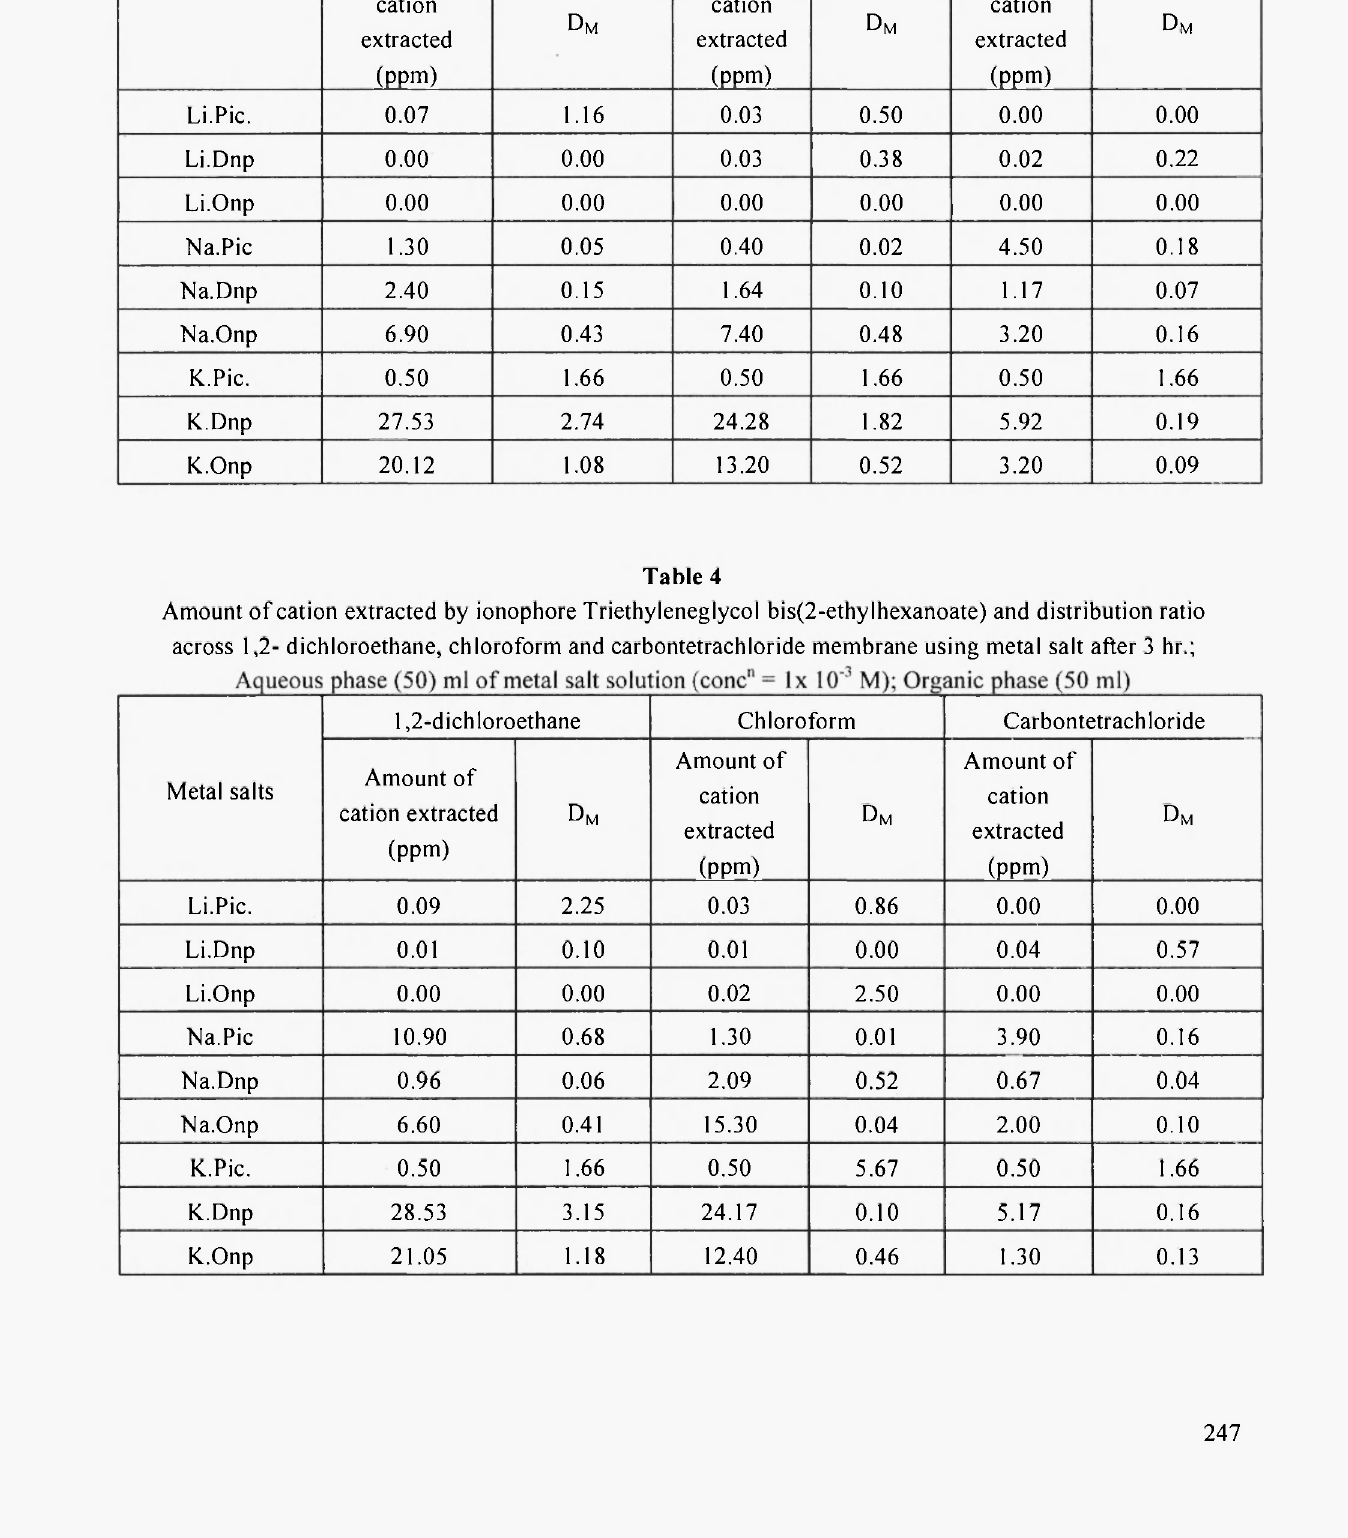
Amount of cation extracted by ionophore Triethyleneglycol bis(2-ethylhexanoate) and distribution ratio across 1,2- dichloroethane, chloroform and carbontetrachloride membrane using metal salt after 2 hrs.;